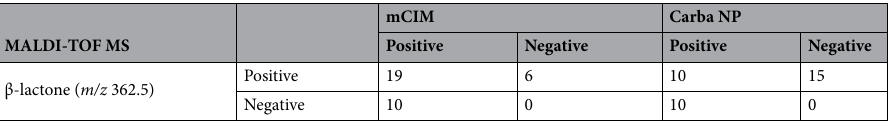
Table 2. Comparison of methods used for a detection of bacteria producing OXA-48-like carbapenemase. All 35 isolates were positive by carbapenemase activity detection using MALDI-TOF mass spectrometry (presence of the peak representing decarboxylated hydrolyzed product or its sodium adduct— m/z 358.5 and 380.5 and/ or β-lactone-corresponding peak— m/z 362.5). Detailed characteristics of the isolates are described in Table